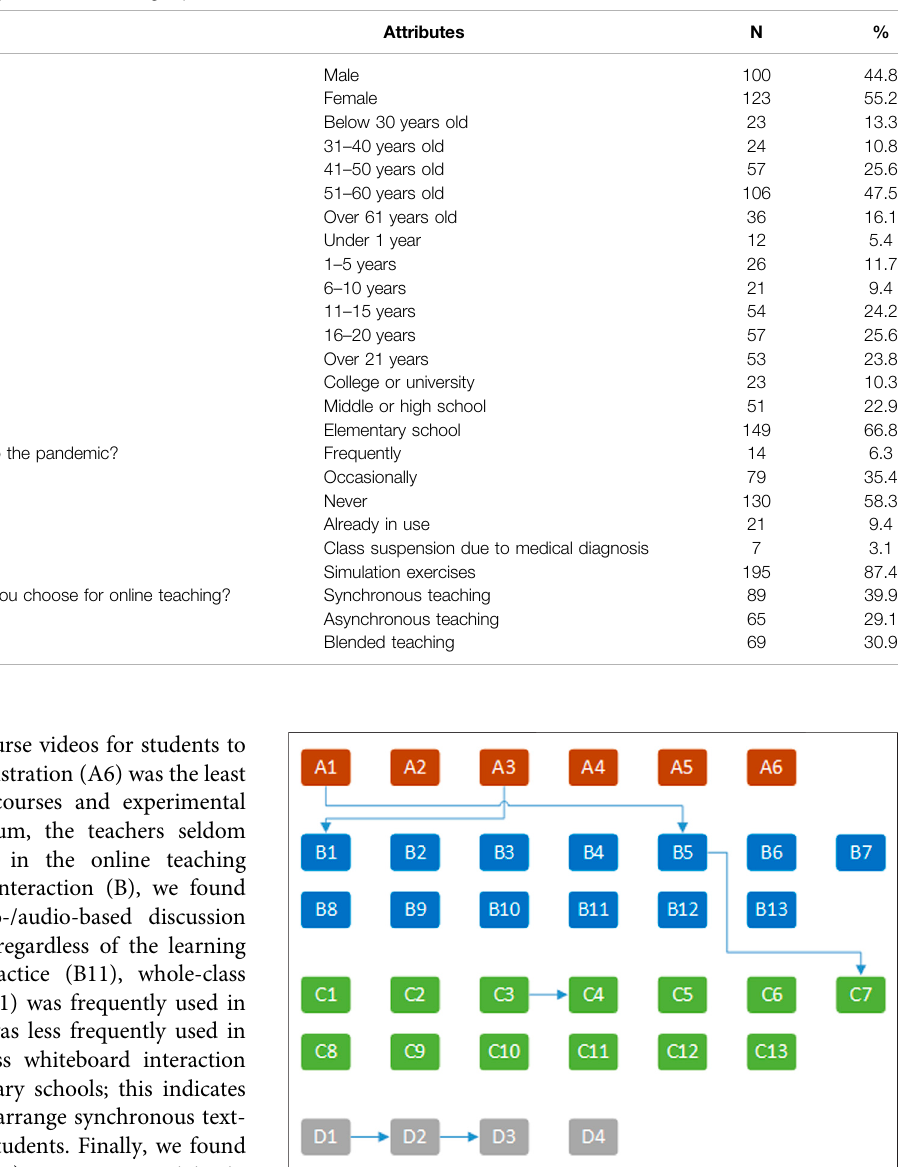
FIGURE 1 | Overall behavioral transfer